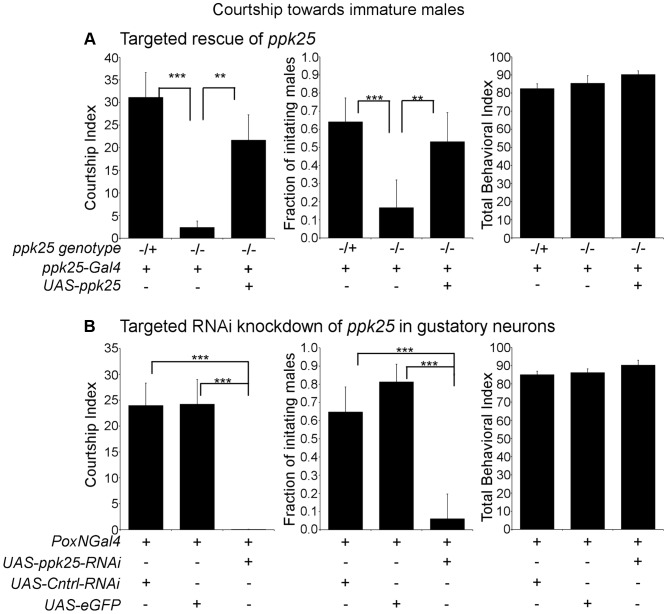
Male courtship of immature males requires ppk25 function.A. ppk25 expression in gustatory neurons defined by ppk25-Gal4 is required for male courtship of immature males. CI, fraction of males initiating courtship toward decapitated immature males and Total Behavioral Index (TBI) were calculated for ppk25 mutant males, control males with one wt copy of ppk25 and for ppk25 null mutant males where ppk25 expression has been restored in cells expressing ppk25-Gal4. N = 32–39; Mean ± SEM; ***p<0.001; **p<0.01 (Error bars indicate the SEM for the fraction of males initiating courtship and statistical significance was determined by Fisher's exact test. Error bars and statistical significance for TBI was determined as described previously for CI). Newly eclosed Canton-S males with light body pigmentation and unfurled wings were used as immature male targets. B. Targeted RNAi knockdown of ppk25 in gustatory neurons with Poxn-Gal4 reduces courtship toward Tai2 males. CI, fraction of males initiating courtship toward decapitated Tai2 males and TBI were calculated for males expressing ppk25 RNAi in gustatory neurons. Control males expressed eGFP or a control RNAi targeting CG13895, a gene with no known involvement in mating behavior [58] in all gustatory neuron. N = 32–34; Mean ± SEM; ***p<0.001.